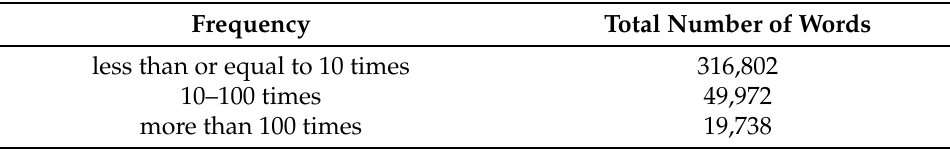
Table 2. Statistics of word frequency in training